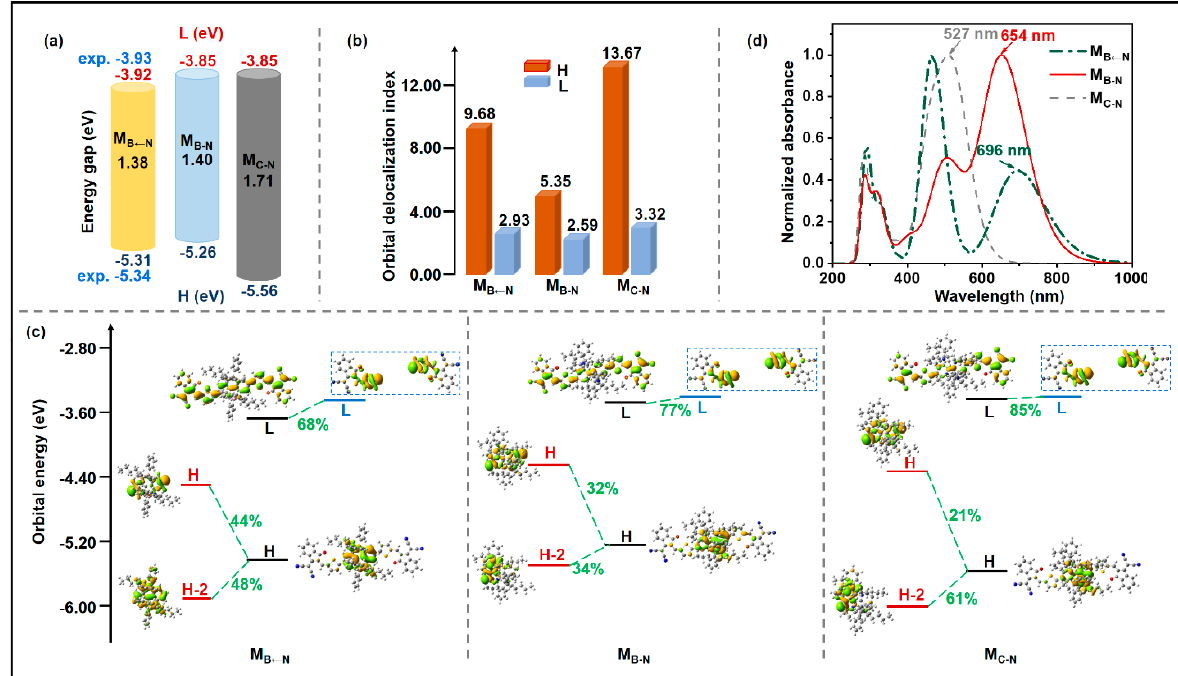
Figure 2. ( a ) Frontier molecular orbital energy levels, ( b ) orbital delocalization index, ( c ) orbital interaction diagram, and ( d ) absorption spectra of M B ← N , M B-N, and M C-N (H: the highest occupied molecular orbital; L: the lowest unoccupied molecular orbital; green texts indicate the major contribution of the molecular orbitals from the fragments to the orbitals of the